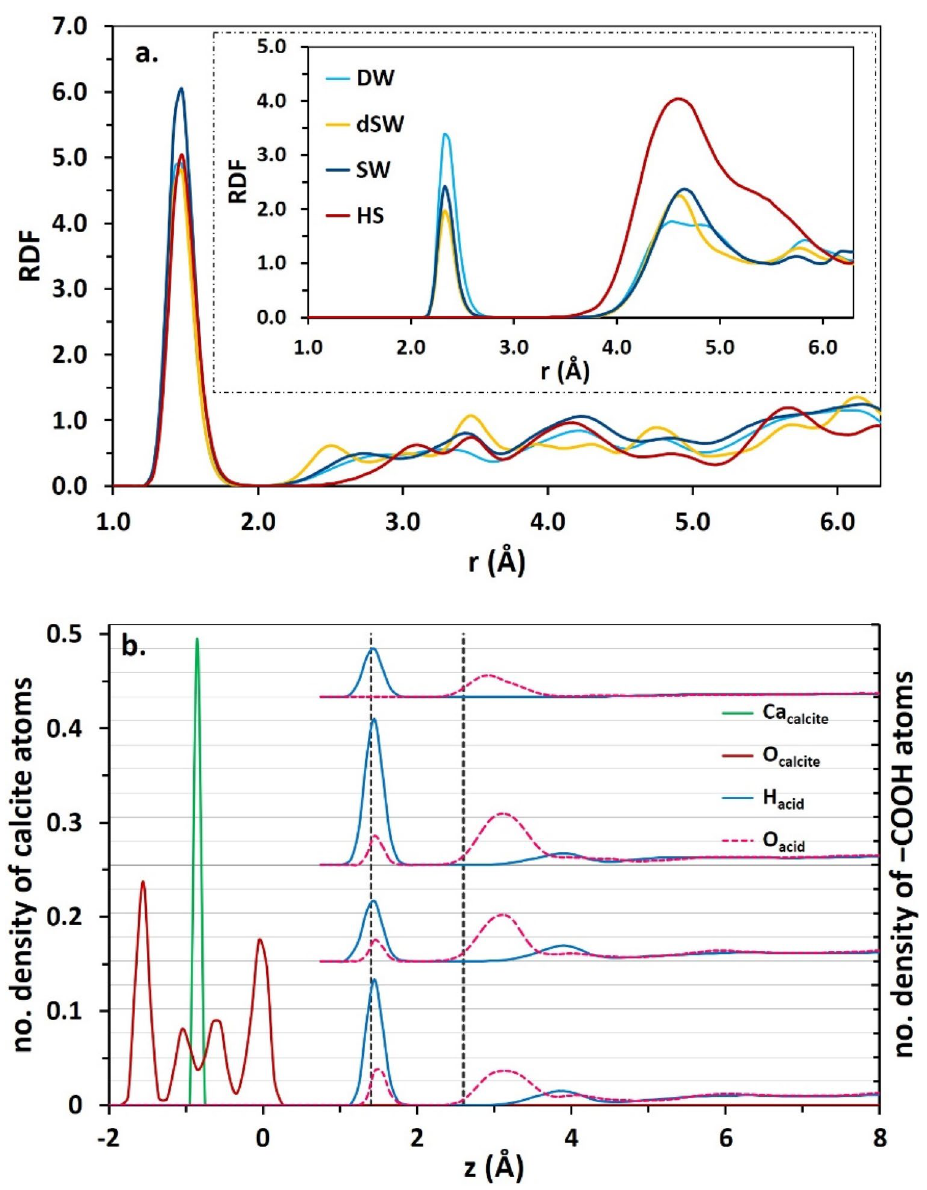
Figure 7. ( a ) RDF of O calcite -H acid (main chart) and Ca-O acid interactions (inset). ( b ) Density profiles of O acid and H acid (the sets in the right approximately beyond 1 Å) with respect to Ca and O calcite . Every set of –COOH densities respectively corresponds to DW, dSW, SW and HS from bottom to top. The gridlines are drawn to compare the scales of H acid and O acid densities at different salinities. The vertical dashed lines refer to the maxima positions of compact hydration layers over